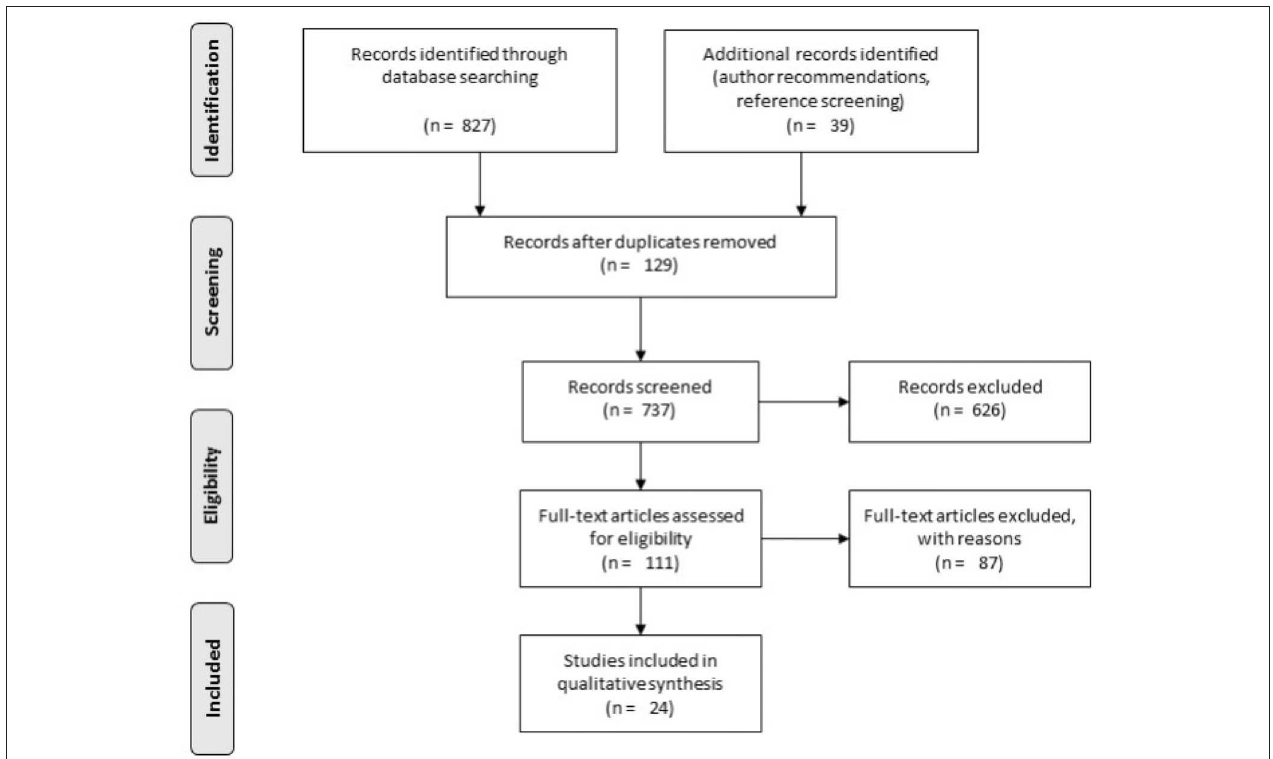
FIGURE 1 | Illustrates the PRISMA search